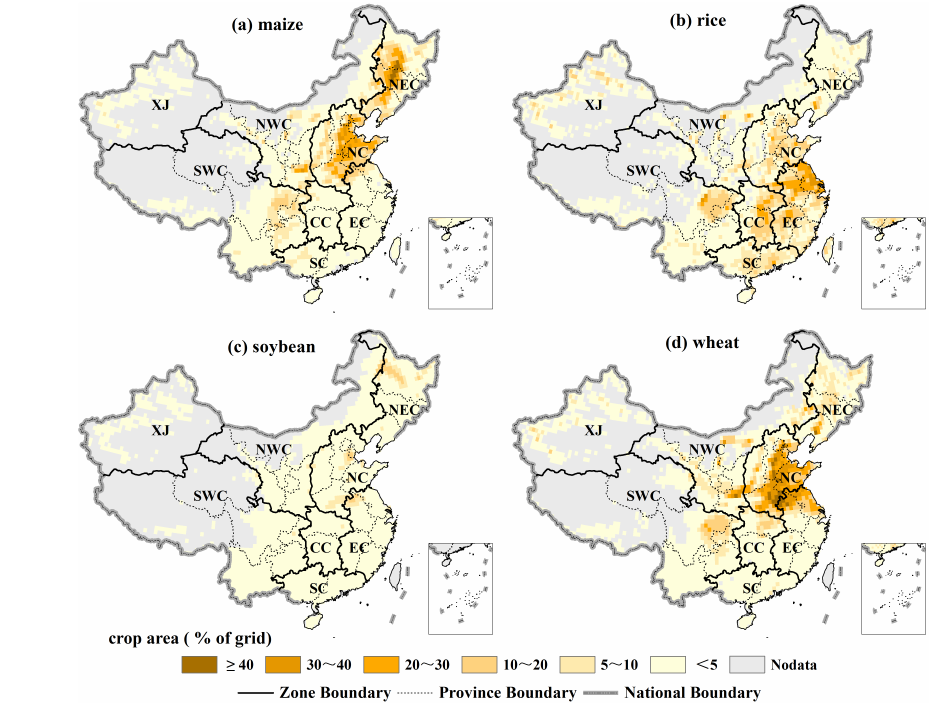
Figure 1. The eight regions in China and the crop area (% of grid area) of maize (a) , rice (b) , soybean (c) and wheat (d) . NEC, NC, EC, SC, CC, SWC, NWC and XJ denote Northeast China, North China, East China, South China, Central China, Southwest China, Northwest China and Xinjiang, respectively.